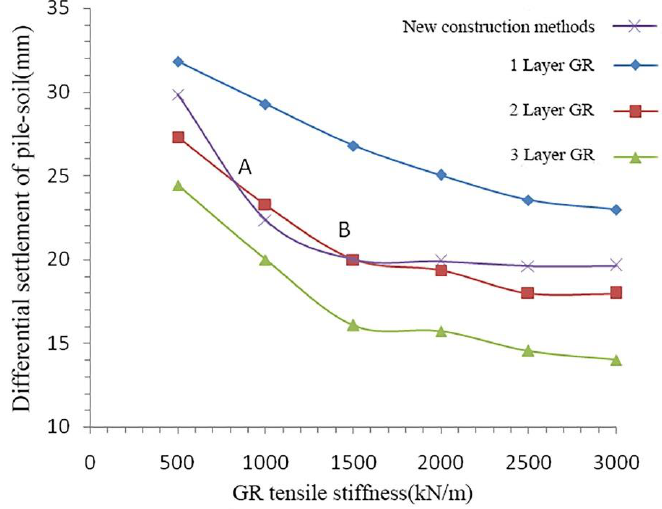
Figure 12. Differential settlement of pile soil with different pile cap sizes and GR tensile stiffness values.